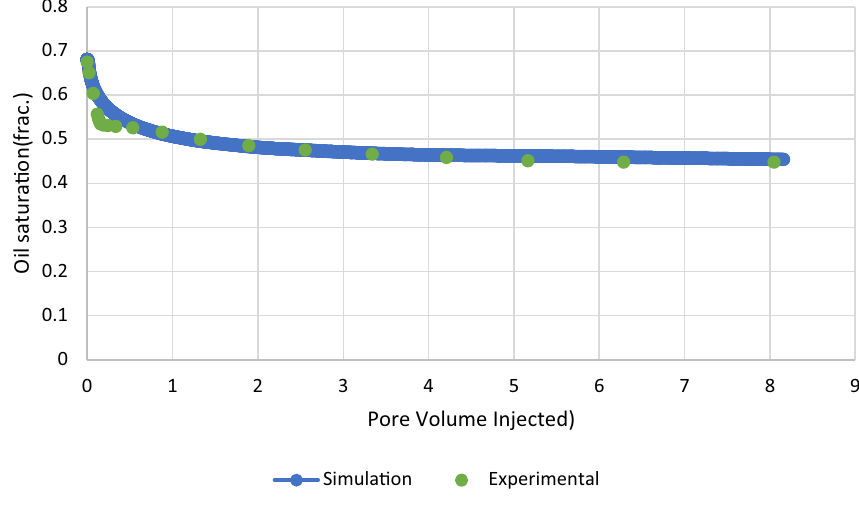
Fig. 13 History matching of oil saturation during water